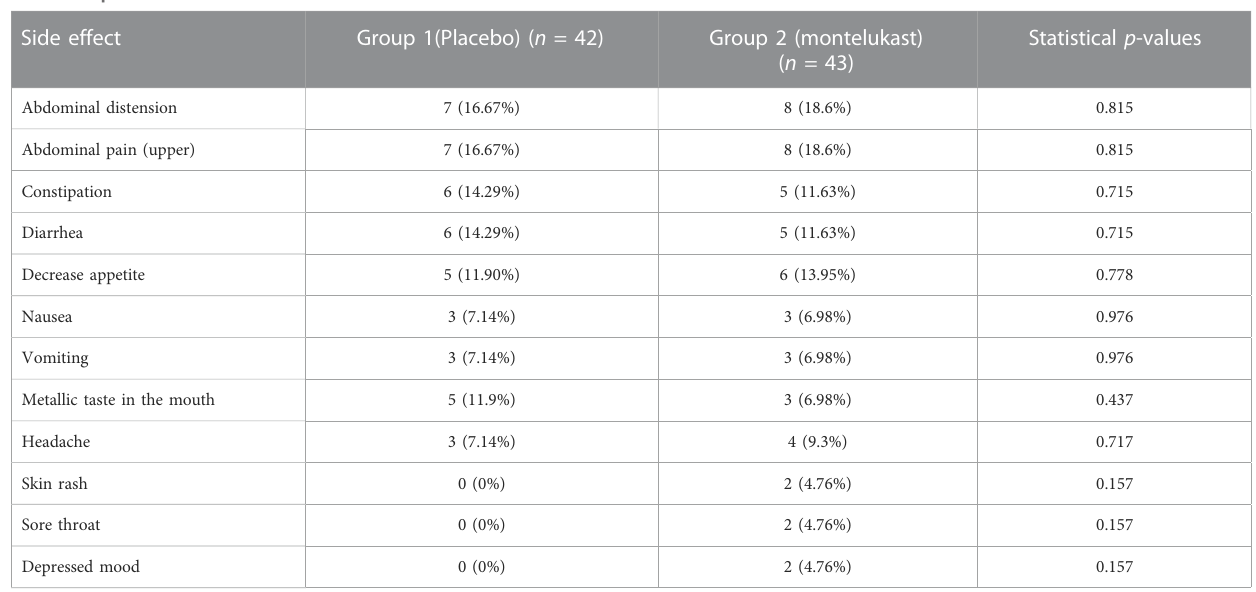
TABLE 4 Reported side